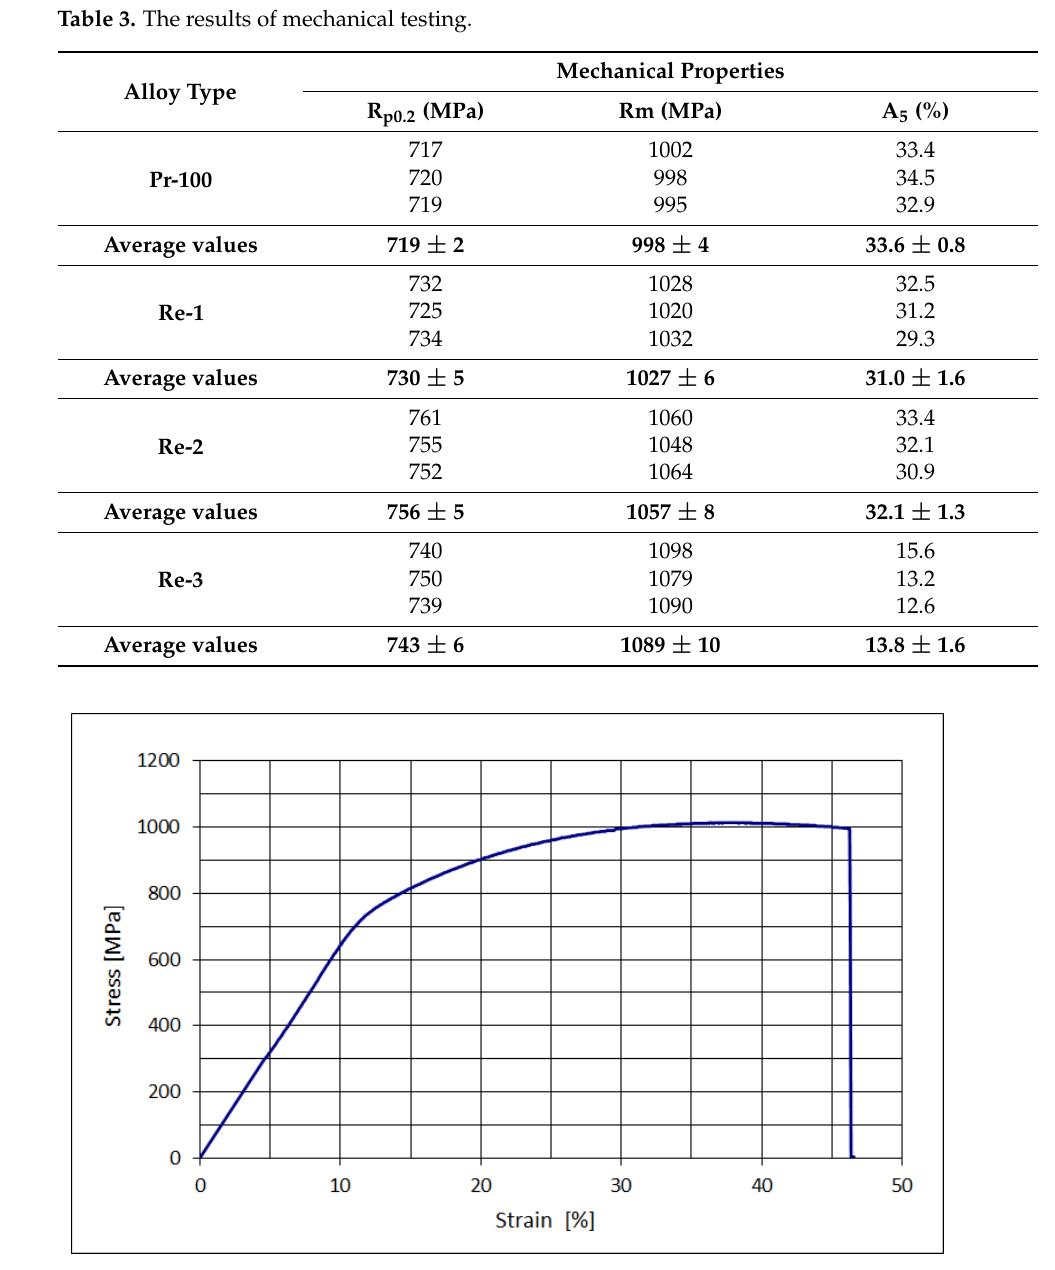
Table 4. The results of microhardness measurements.